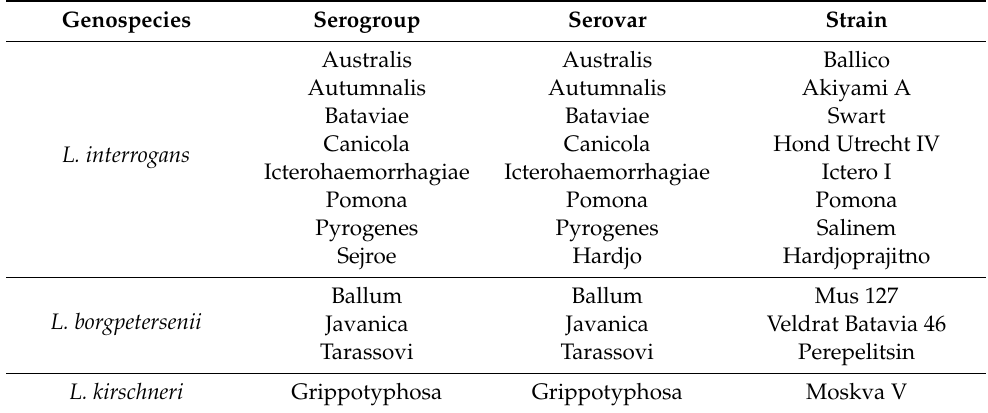
Table 1. Panel of Leptospira spp. strains used as antigens in the microscopic agglutination test (MAT). Genospecies Serogroup